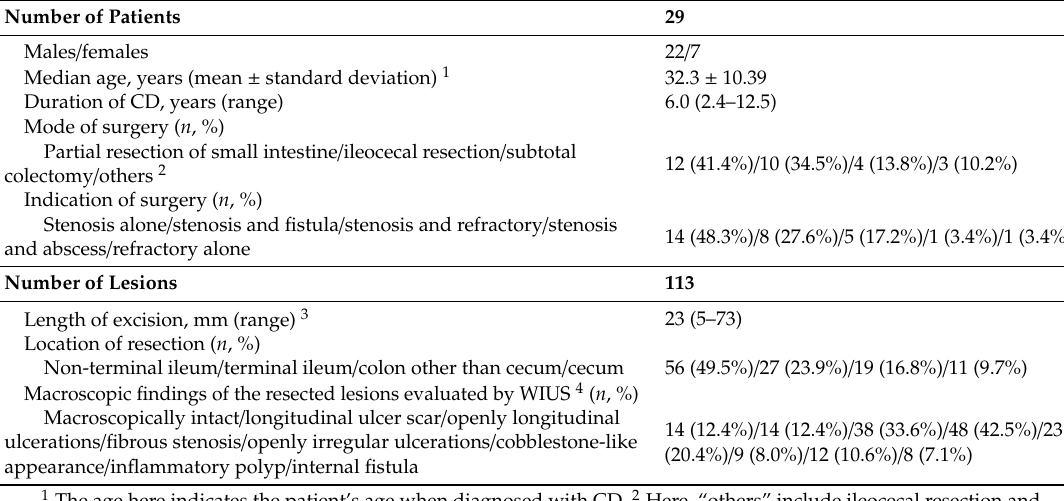
Table 1. Baseline characteristics of enrolled